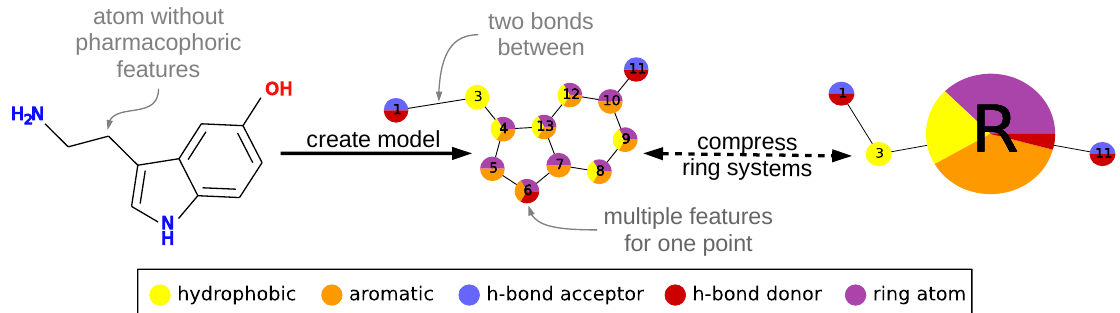
Figure 1. An example of creating a pharmacophore model from a single molecule. Atoms are converted into nodes and labeled with pharmacophoric features. During alignment, ring features are used to reduce the model to improve performance. Nodes numbering in the graph visualization corresponds to atom